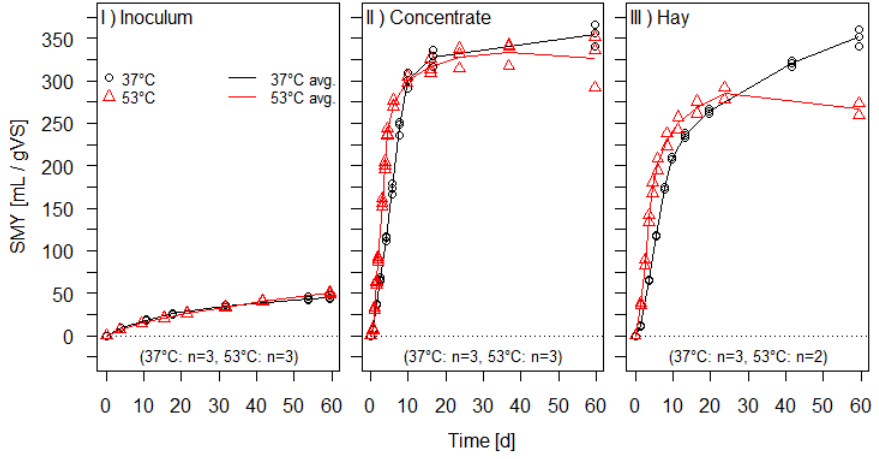
Figure 2. Measured specific methane yields for ( I ) inoculum, ( II ) concentrate, and ( III ) hay under mesophilic and thermophilic conditions.